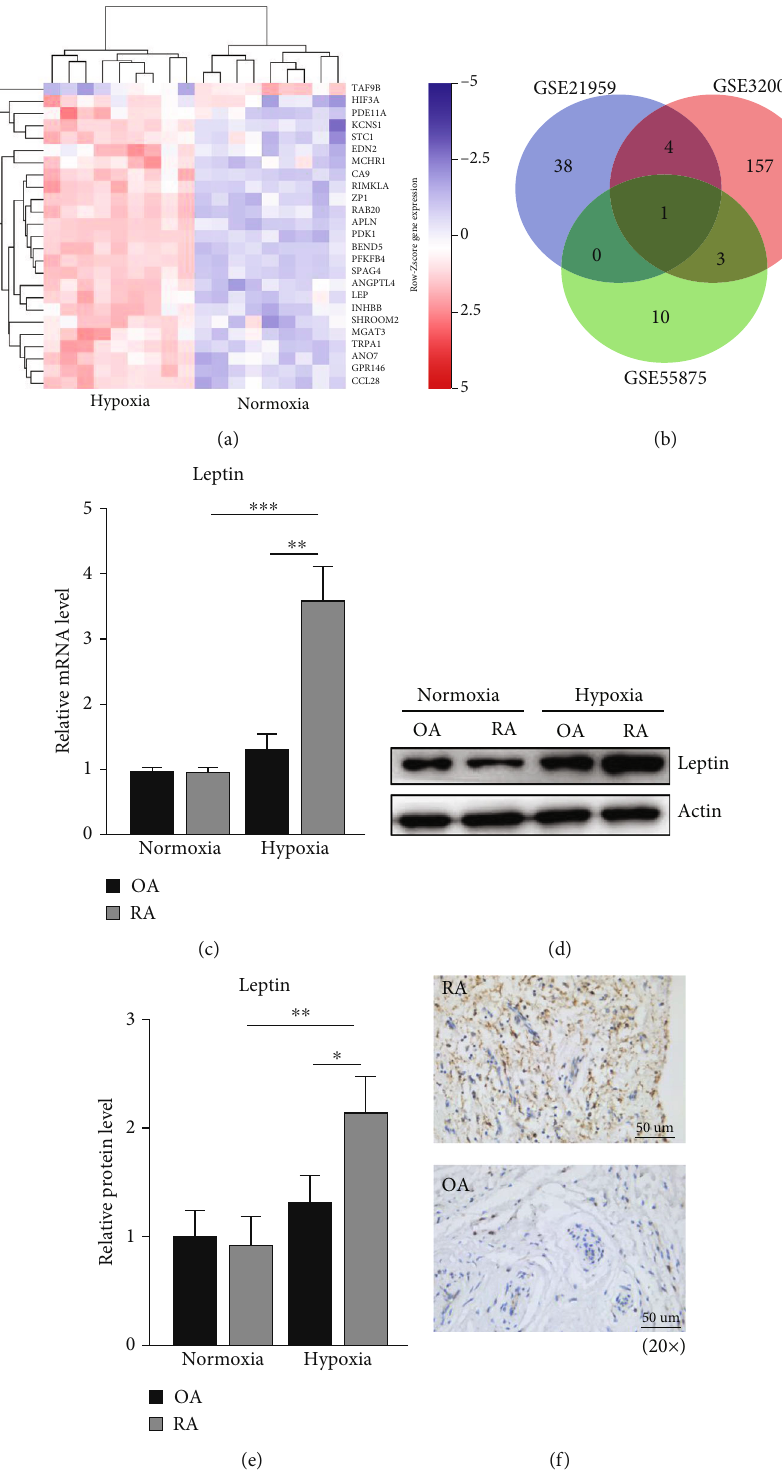
Figure 3: Hypoxia increases leptin expression of RA-FLSs. (a) Heat map shows the hierarchical clustering of RA-FLSs cultured under hypoxic and normoxic conditions. (b) Venn diagram illustrates the overlap of DEGs data from three independent analyses. (c) RT-qPCR analysis shows the expression of LEPin RA-FLSs and OA-FLSs after 48 hr hypoxia or normoxia treatment. The experiments were repeated three times. Data quanti fi cation is mean ± SEM . (d, e) Western blot shows leptin expression in RA-FLSs and OA-FLSs after 48hr hypoxia or normoxia treatment. β -Actin was used as an internal control. The experiments were repeated three times. Data quanti fi cation is mean ± SEM. (f) The distribution of leptin in synovium samples obtained from patients with RA or OA. ∗ p < 0 : 05 , ∗∗ p < 0 : 01 , ∗∗∗ p < 0 : 001 . Scale bars: C = 50 μ m